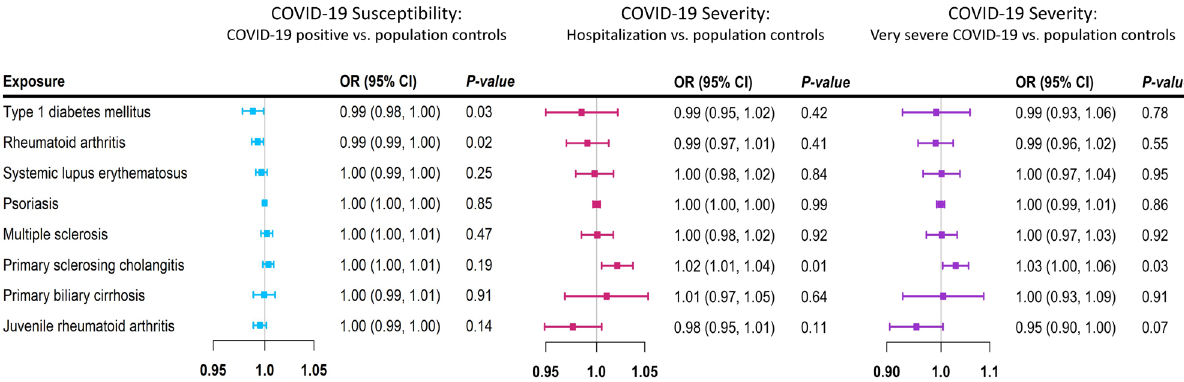
Figure 2. Mendelian randomization (MR) estimates of sensitivity analysis for each autoimmune disease and COVID-19. Forest plot of Mendelian randomization (MR) estimates of 8 autoimmune diseases with COVID- 19 infection, hospitalized COVID-19 and very severe COVID-19 using the multiplicative random-effects inverse variance weighting method after excluding genetic variants in the human leukocyte antigen region. The black color represents COVID-19 infection, the blue color represents hospitalized COVID-19 and the red color represents very severe COVID-19. MR estimates are reported as odds ratios per unit of log-odds of each autoimmune disease